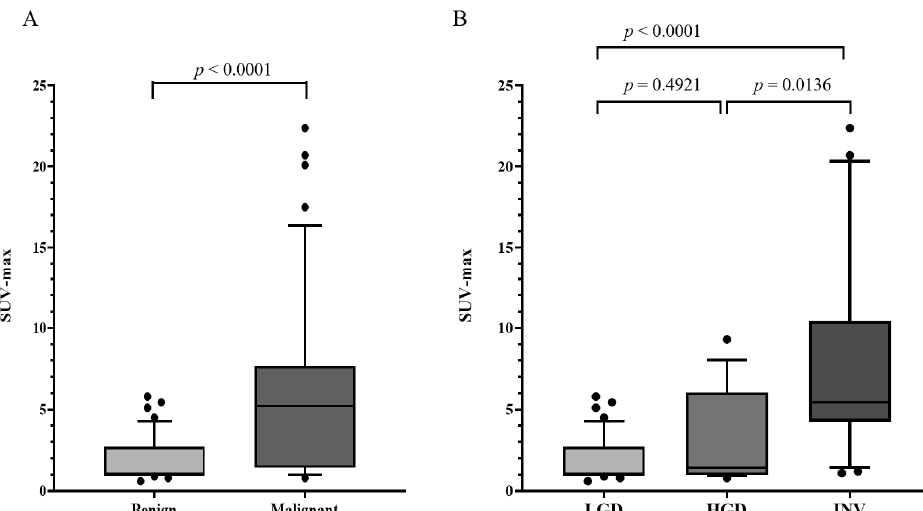
Figure 2. Box plot of the levels of SUV-max in the late phase. ( A ) Box plot of the levels of SUV-max in the benign group and malignant group are shown; SUV-max was significantly higher in the malignant group compared with the benign group ( p < 0.0001). ( B ) Box plot of the levels of SUV-max in the LGD, HGD, and INV groups; SUV-max was significantly higher in the INV group that in the LGD and HGD groups ( p < 0.0001, p = 0.0136, respectively). There was no significant difference in the levels of SUV-max between the LGD and HGD groups. SUV-max: maximum standardized uptake value; LGD: low-grade dysplasia; HGD: high-grade dysplasia; INV: invasive cancer.